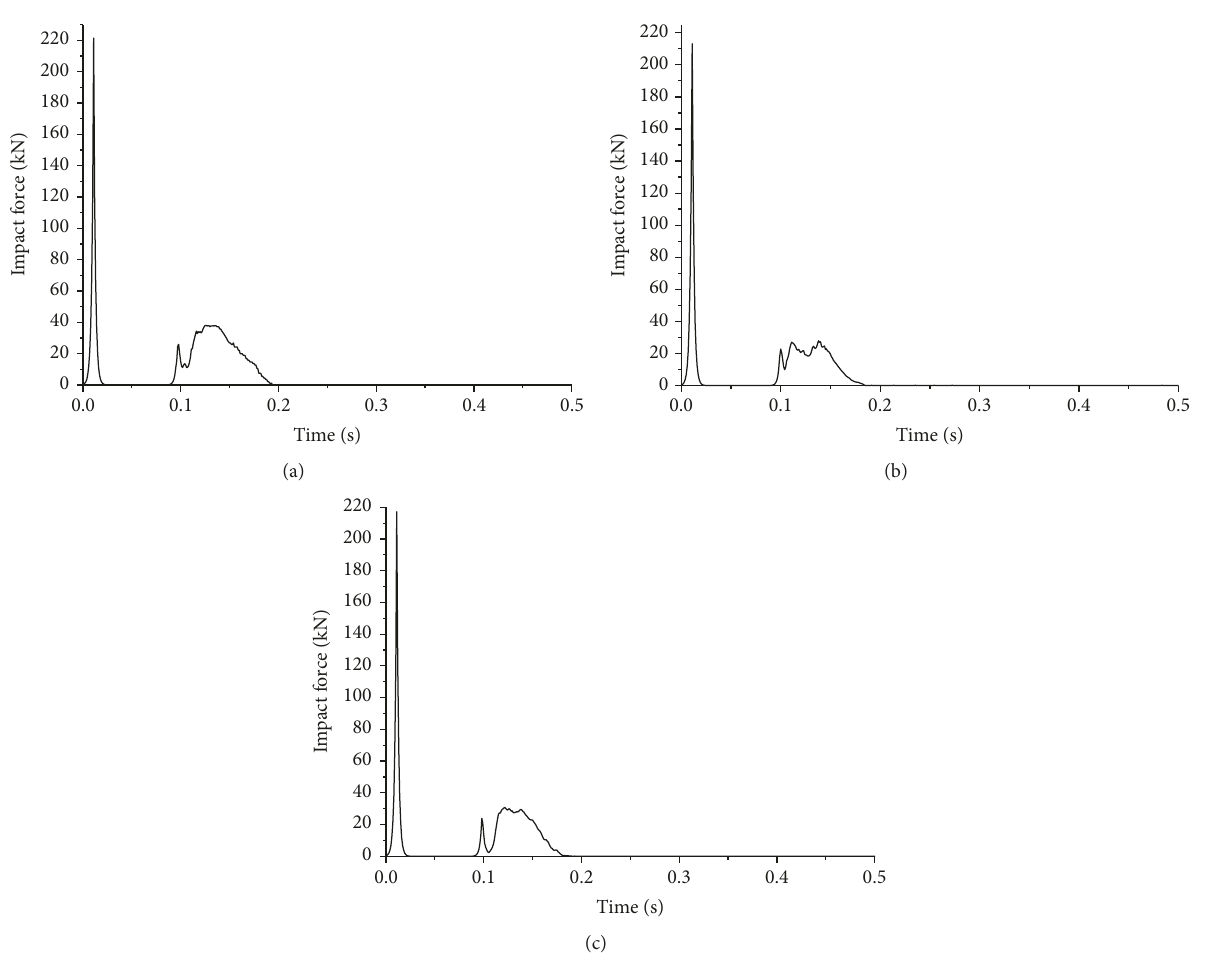
Figure 16: Impact time history curve: (a) model 7, (b) model 8, and (c) model